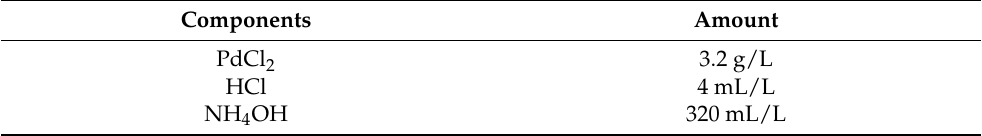
Table 1. Compositions of EDTA-free baths for electroless Pd